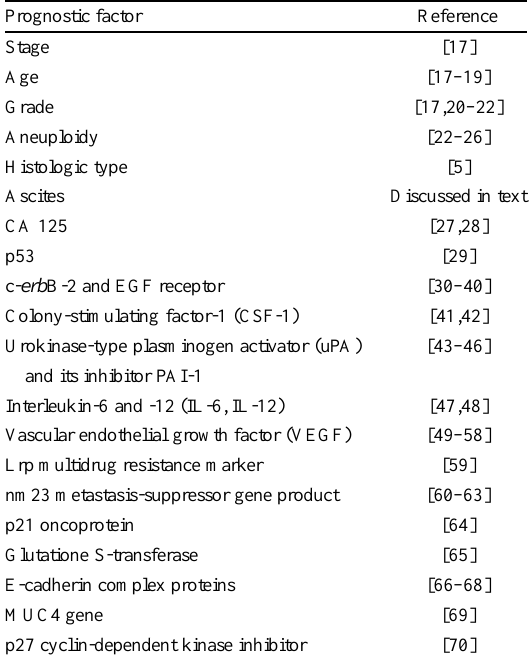
Possible prognostic factors in ovarian